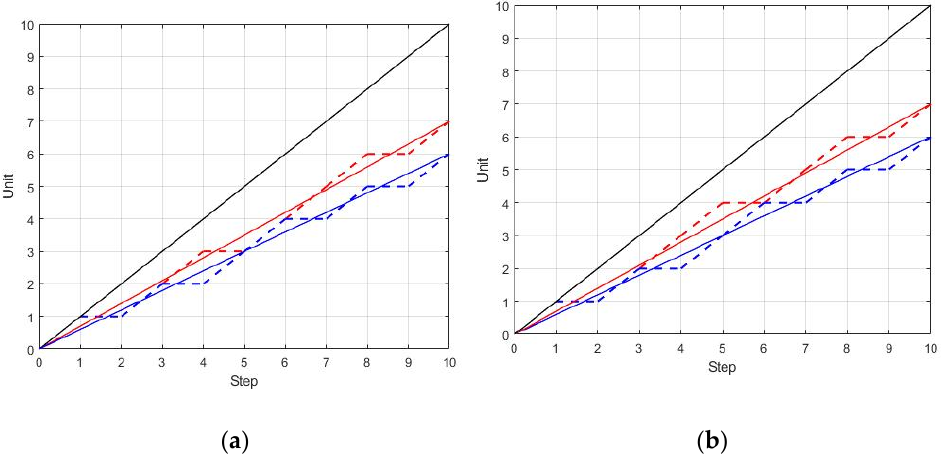
Figure 11 . Differences between two different algorithms . ( a ) Line generation based on Liu’s algorithm Figure 11. Di ff erences between two di ff erent algorithms. ( a ) Line generation based on Liu’s algorithm